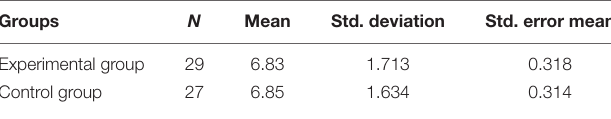
TABLE 5 | Descriptive statistics of pre-test